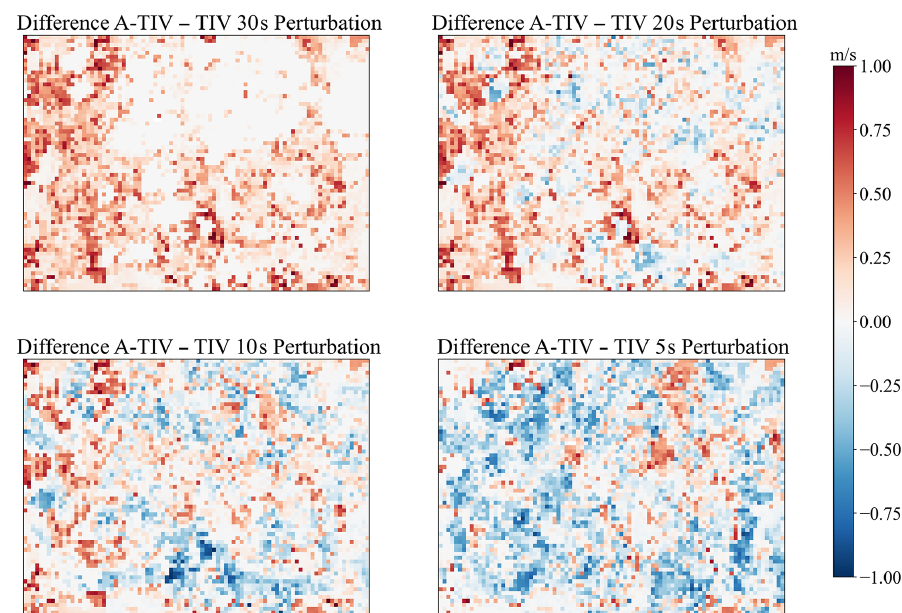
Figure 8. A-TIV wind speed difference compared to the TIV result of TURF-T1 for an example frame – red indicates that the A-TIV result exhibits a higher speed than the corresponding TIV result. A positive difference means that all the other TIVs add velocity information to these pixels according to their weights (respectively meaning no velocity information is gained from this TIV pixel). A negative value means that velocity information is added from this pixel. A value close to zero means that the TIV of this pixel matches the A-TIV value. All velocity information gains and losses are changes in respect to the weight, which is defined by the perturbation filter time. A-TIV therefore gains information from different TIVs and creates an average measurement over various perturbation scales.